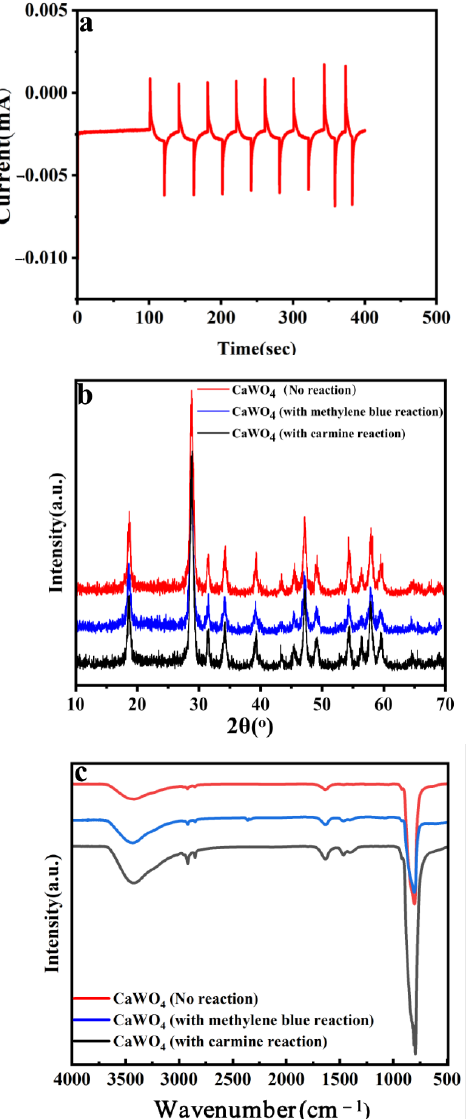
Figure 6. ( a ) I-t curves obtained at 0.0 V where 100 mM Na 2 SO 4 was used as electrolyte; ( b ) XRD patterns of CaWO 4 (no reaction), CaWO 4 (with MB reaction), and CaWO 4 (with CR reaction); ( c ) FT-IR spectra of CaWO 4 (original sample), CaWO 4 (after reaction with MB), and CaWO 4 (after reaction with CR).